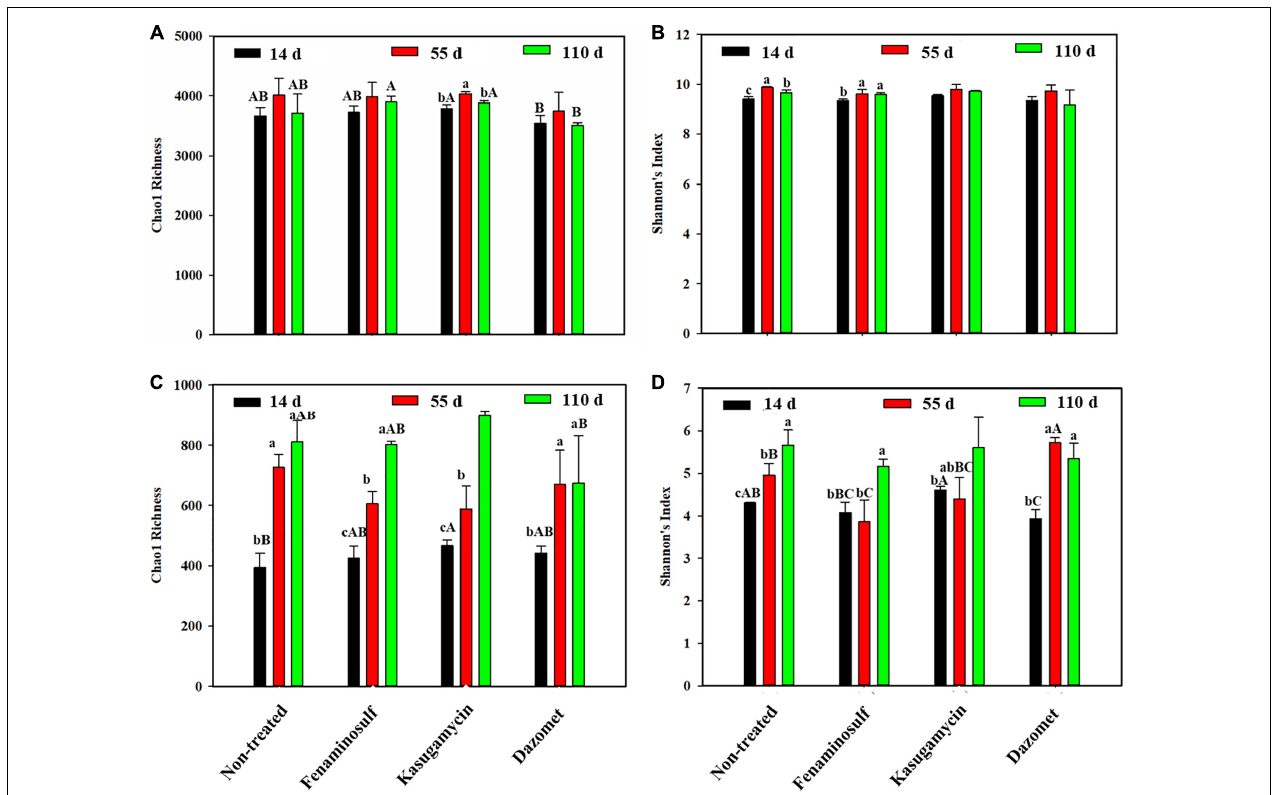
FIGURE 2 | Chao1 richness and Shannon diversity of bacteria (A,B) and fungi (C,D) in (A) non-treated soil and soils treated with (B) fenaminosulf, (C) kasugamycin, and (D) dazomet. Values represent mean ± standard deviation of triplicate measurements. Different lowercase letters in the same column indicate significant differences ( p < 0.05) at different sampling times in one treatment, and different capital letters indicate significant differences ( p < 0.05) among different treatments at a particular sampling time.